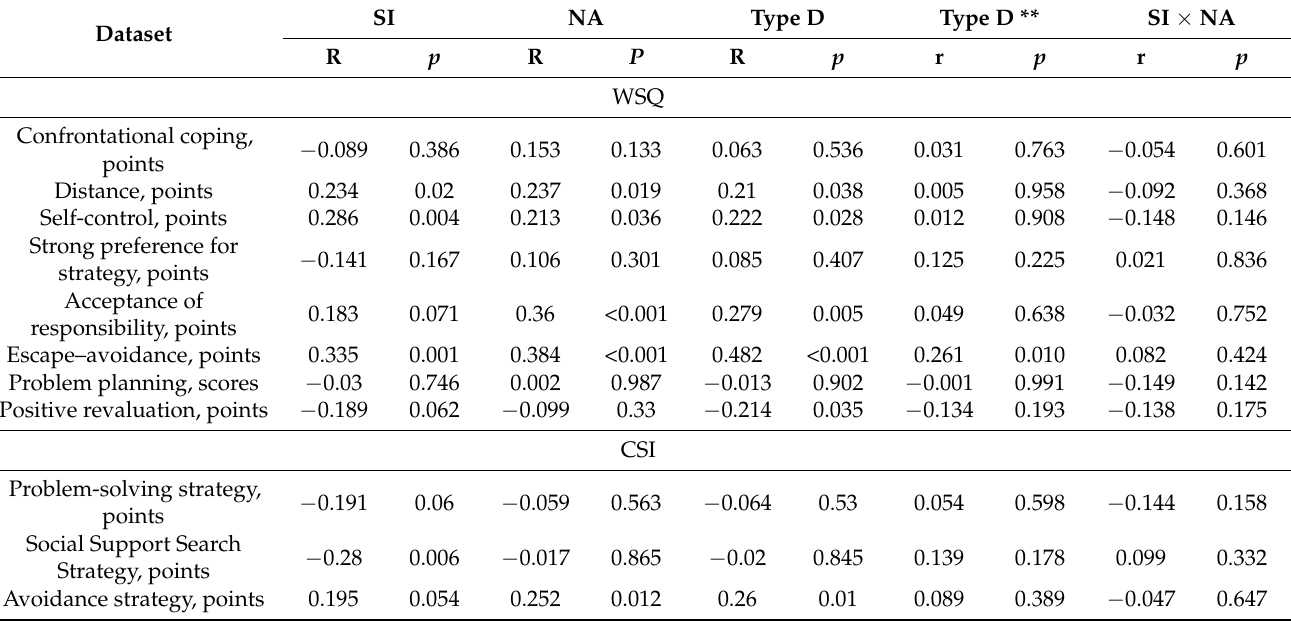
Table 4. Correlation type D, NA, SI, and WSQ/CSI